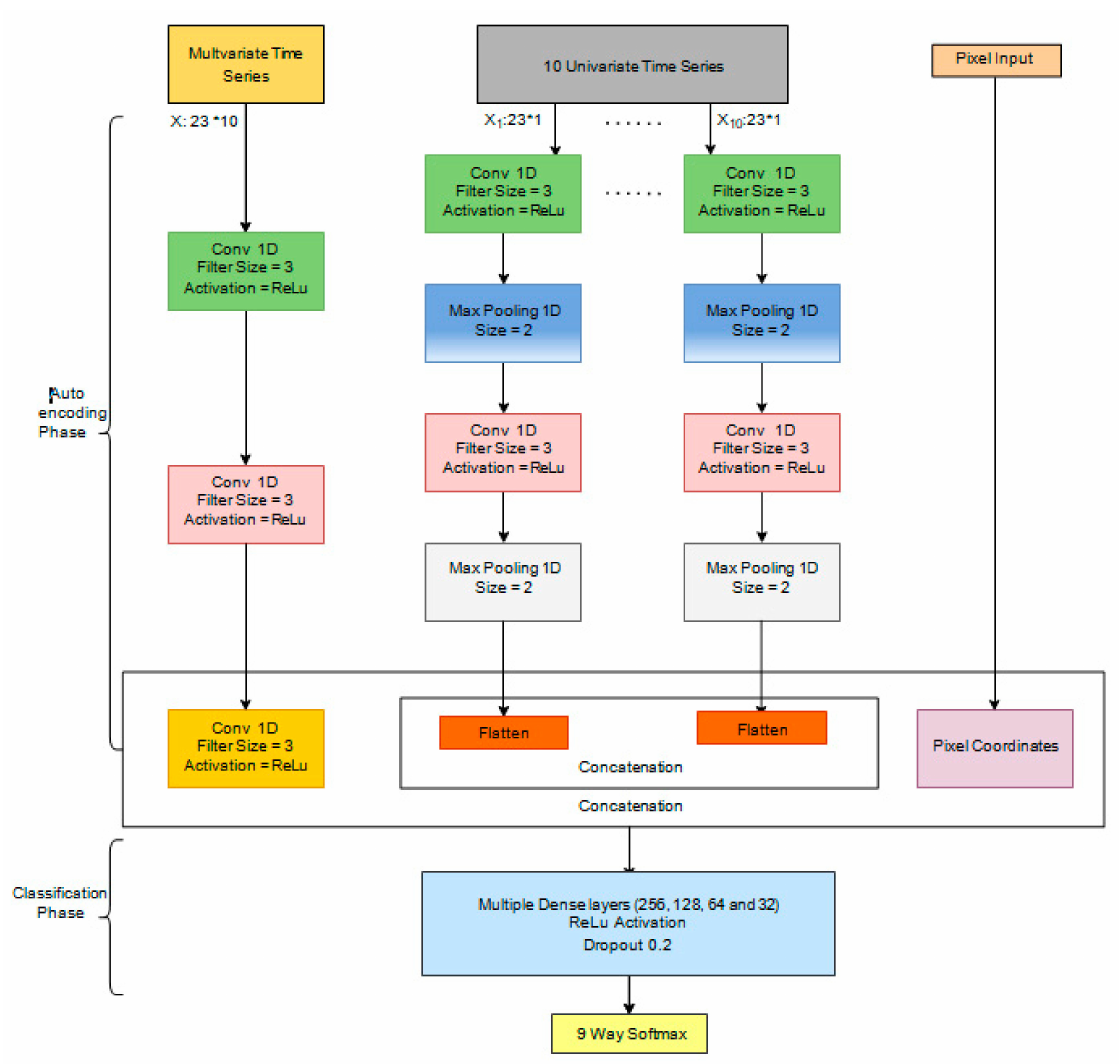
Figure 5. Proposed framework of univariate + multivariate + pixel coordinates for land cover